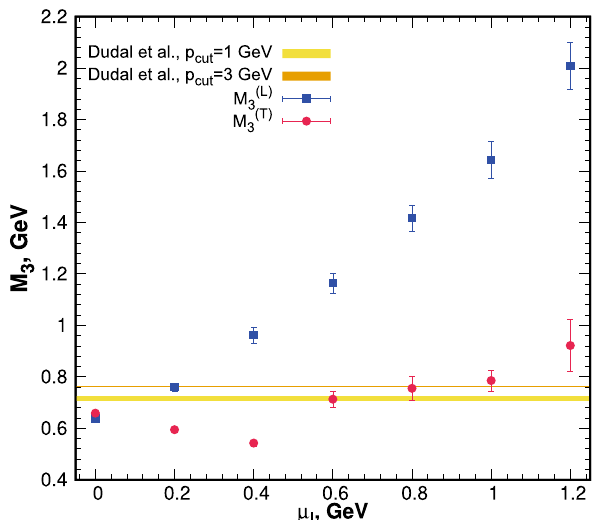
Fig. 6 Parameter M 3 of the GS fit (23) as a function of μ I . Yellow strip shows the result obtained in [55] with p cut = 1 GeV, brown strip – with p cut = 3 GeV